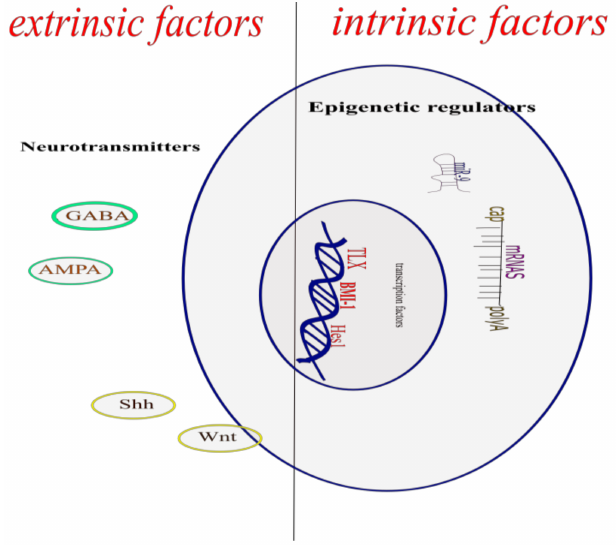
Figure 1. Molecular mechanism that regulates the differentiation of neuronal stem